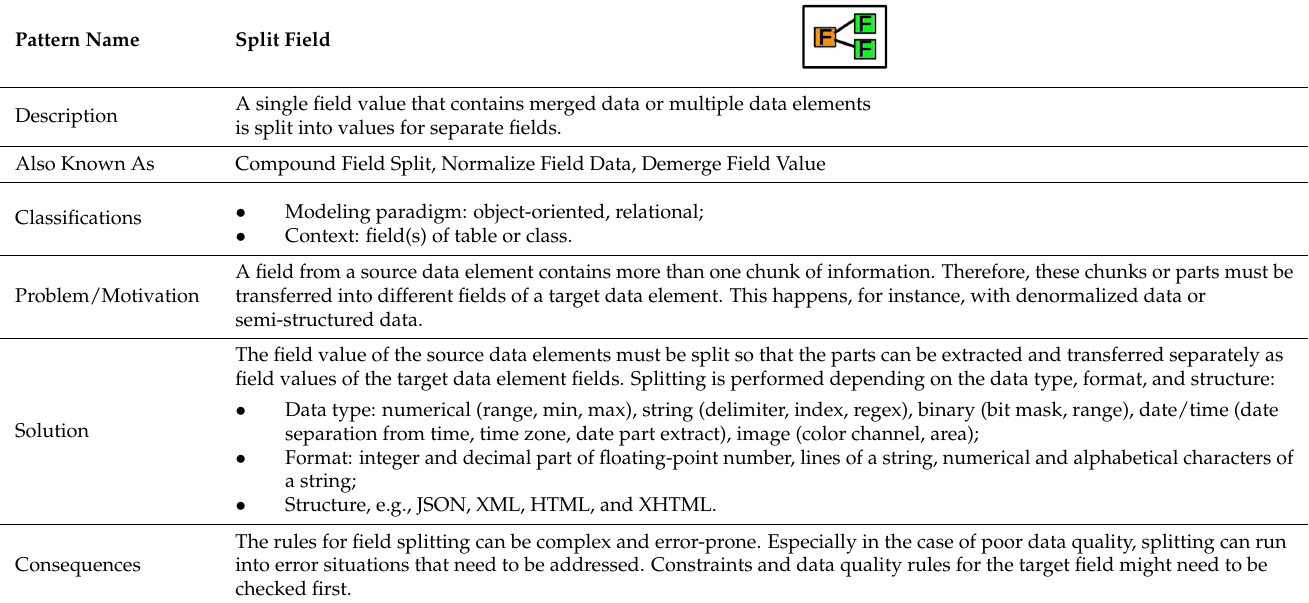
Table 2. Detailed pattern definition for data integration pattern “Split Field”.